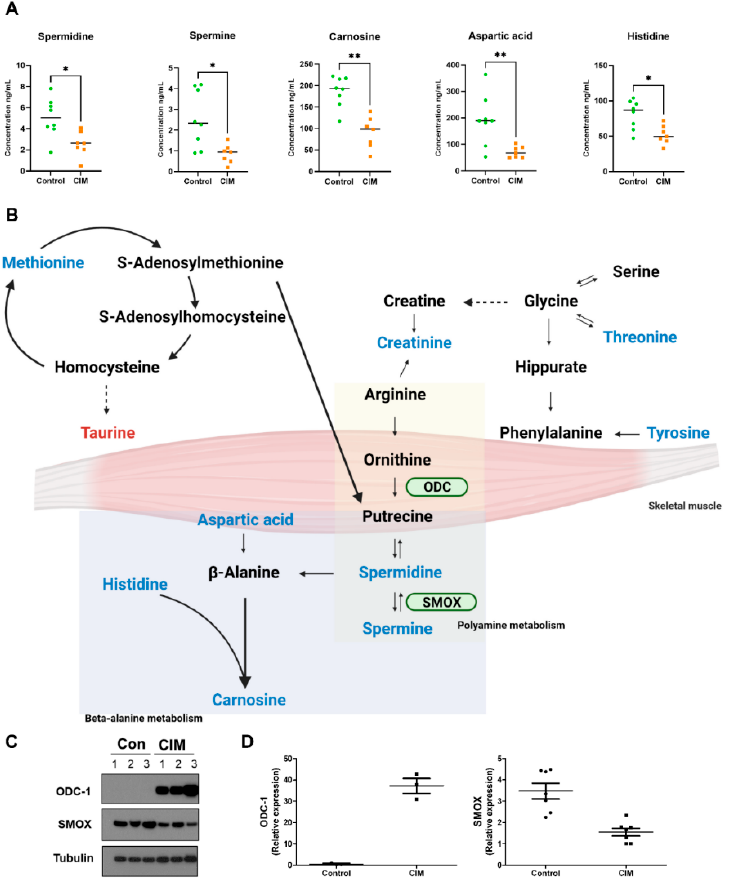
Figure 4. IIM-related metabolite alterations and pathways in muscle tissue. ( A ) Individual scatter plots of significant metabolites related to important pathways in mouse tissue. ( B ) Overview of altered metabolites related to the skeletal muscle tissue of mice. Red-colored metabolite indicates up-regulation in CIM mice, while blue-colored metabolites represent down-regulation as compared with the control mice. ( C ) Protein expression and ( D ) relative quantitative data of ODC-1, SMOX, and tubulin. (* p < 0.05, ** p <